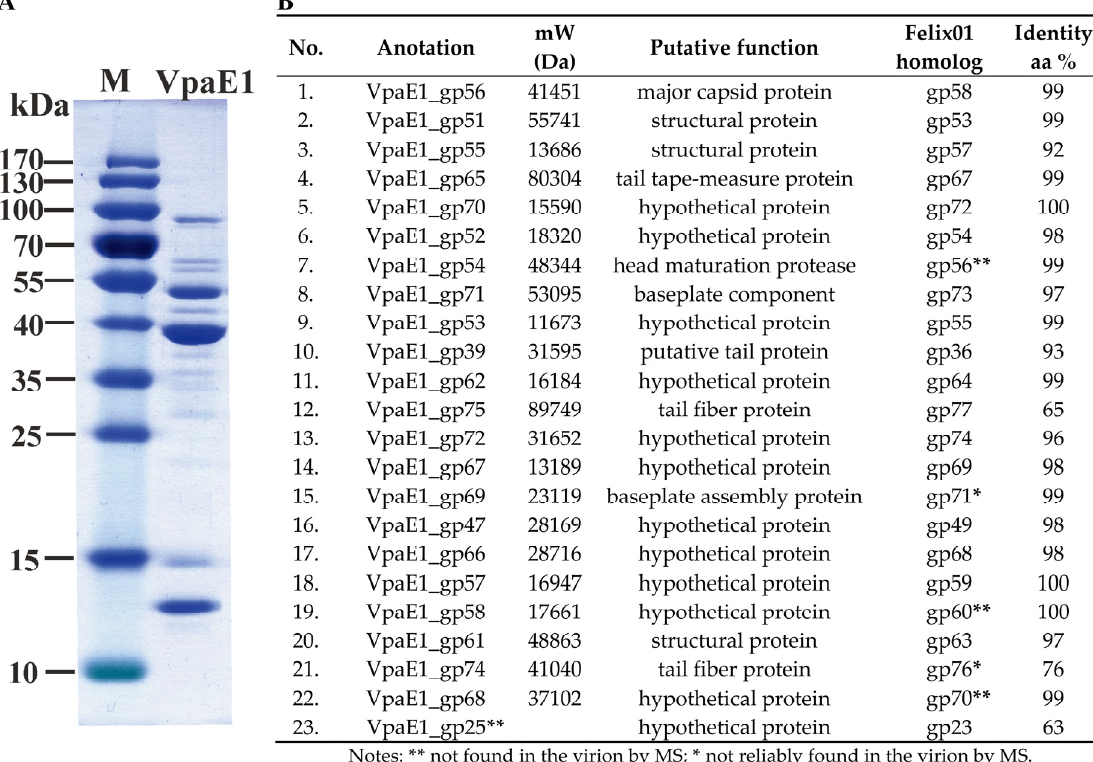
Figure 5. Analysis of protein composition of VpaE1 virion: ( A ) SDS-PAGE analysis of phage VpaE1 particles; and ( B ) the list of VpaE1 structural proteins identified by MS in comparison with those in the virion of Felix01 identified previously [19].